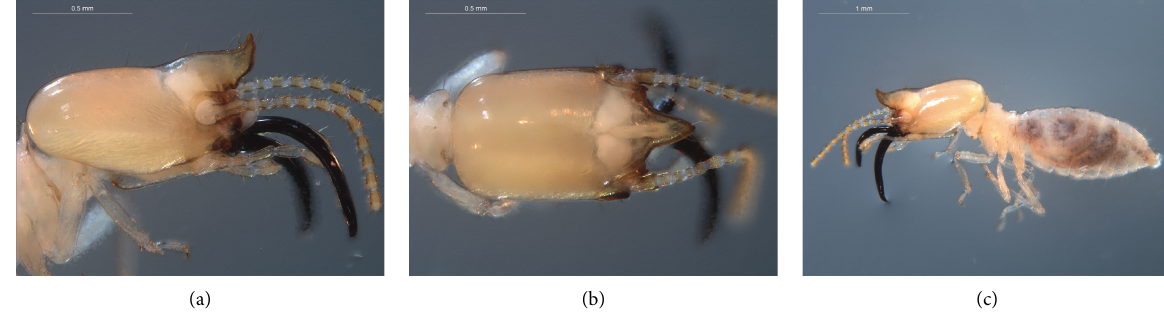
Figure 1: (a) Termes propinquus in lateral view. (b) Termes propinquus in dorsal view. (c) Termes propinquus body in lateral view.